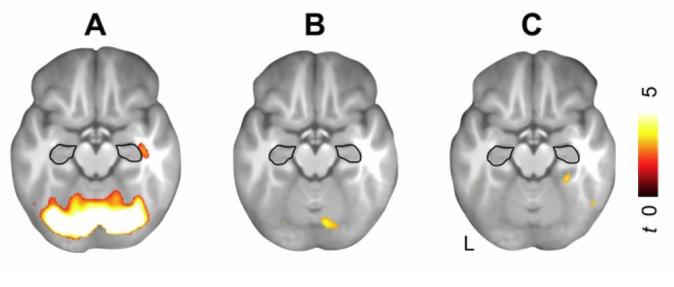
Hippocampal activation during schema retrieval (z = -17).(A) Increased BOLD responses during schema memory retrieval across both days (schema retrieval > perceptual baseline), (B) during rule-based schema retrieval on day 1 (day 1 > day 2), and (C) after an initial consolidation of 24 hours (day 2 > day 1). Contrasts include runs 5 to 7 from day 1, and run 1 from day 2. For display purposes, results were resliced to a voxel dimension of 0.5 mm isotropic and are shown at P < 0.001, uncorrected. Significant clusters are noted in Table 6 (updated manuscript). Results are superimposed onto the average structural scan derived from all subjects. The hippocampus is schematically outlined in black (based on the anatomical definition of the AAL atlas). L – left.